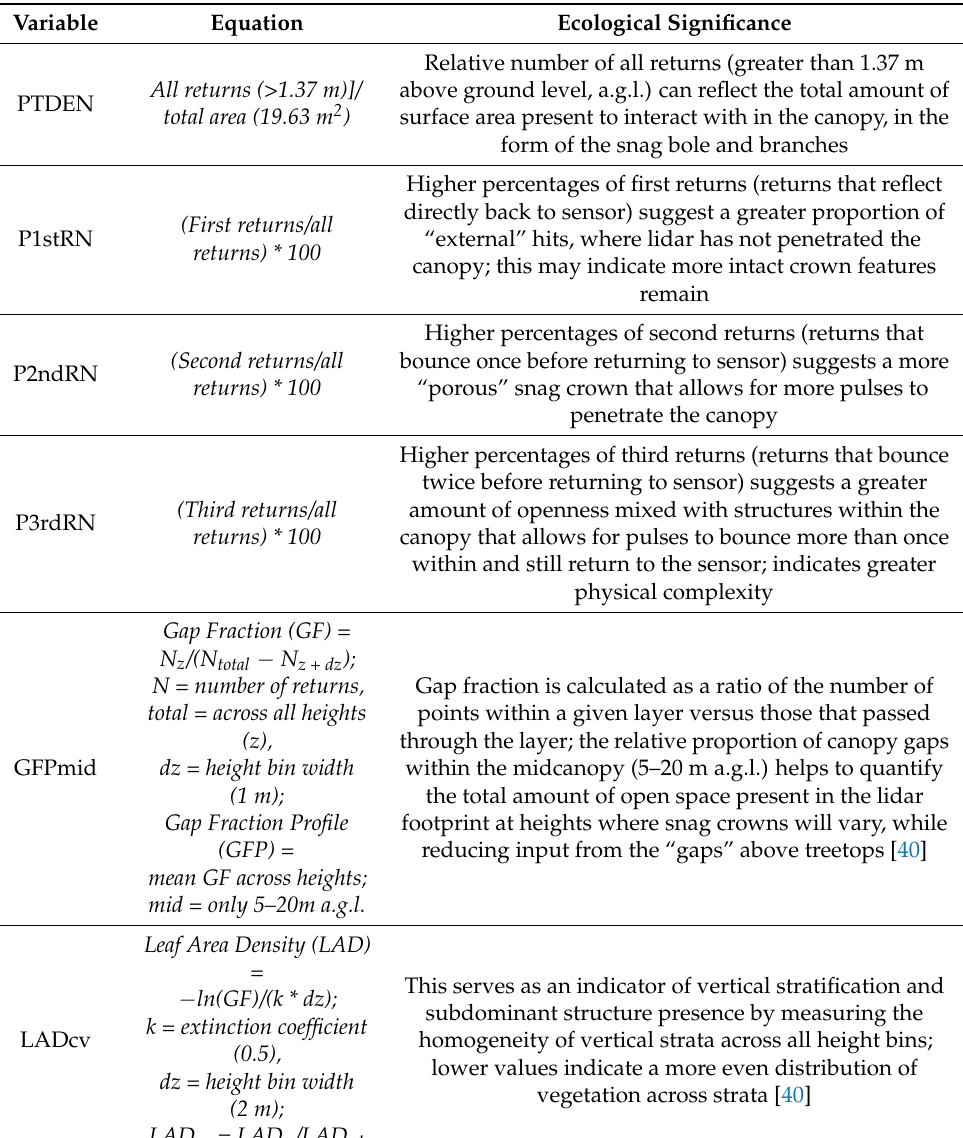
Table A1. Airborne-lidar-derived metrics used as predictor variables in random forest (RF) models. Explanations of each of the lidar-derived predictor variables selected for analysis within the RF models are provided. All of these predictors were included in model selection to predict one of four snag classes, modeled across two field-derived characteristics: diameter (small (<40 cm DBH) vs. large ( ≥ 40 cm DBH)) and intactness of the bole (intact vs. broken). Airborne lidar metrics were derived from point clouds of 2.5 m circular radius (~20 m 2 ) clipped around known snag locations determined from the field. Each variable is listed with its abbreviation, description of the calculation, and the ecological significance for this